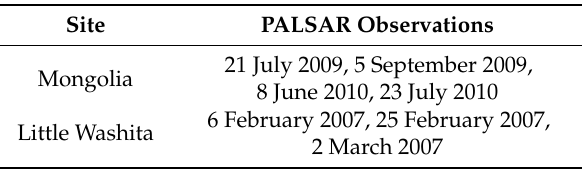
Table 1. Dates of PALSAR